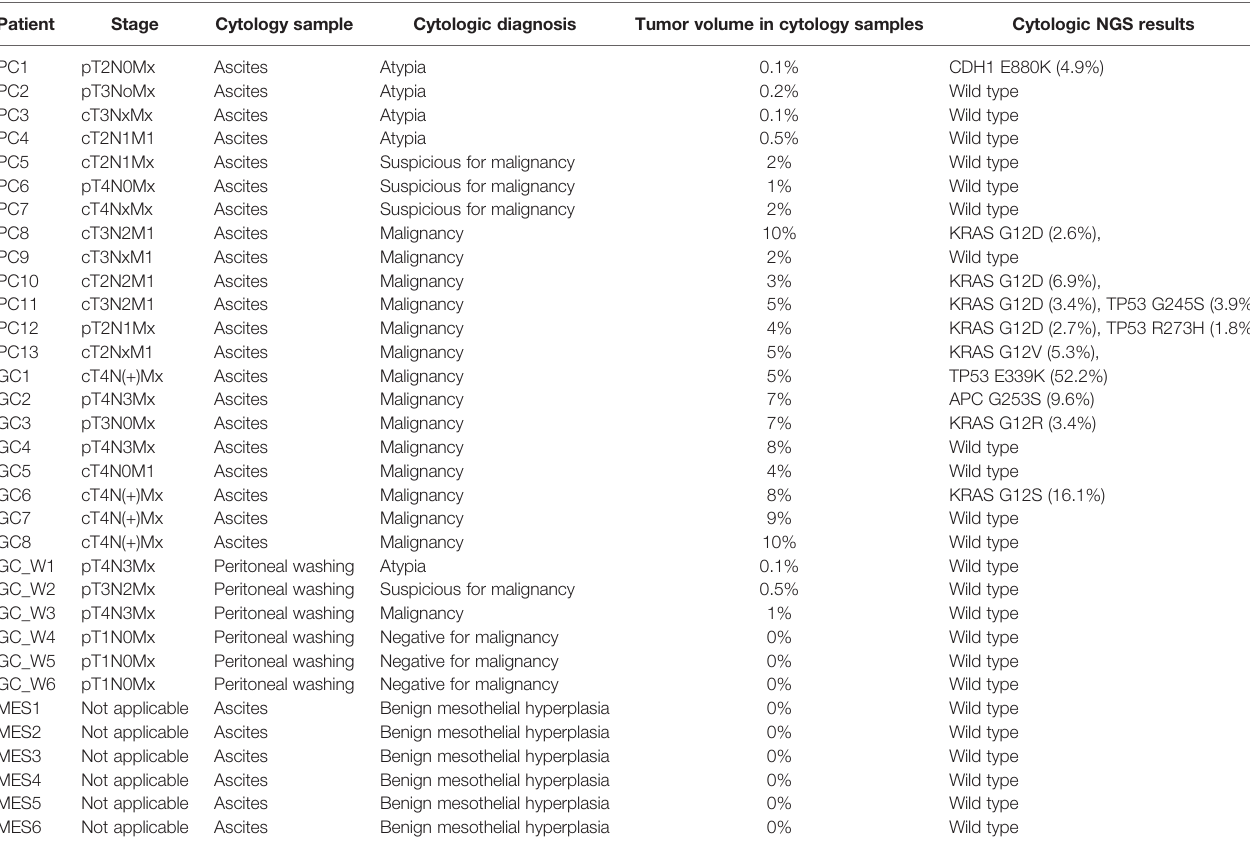
TABLE 4 | NGS results of cells obtained from ascites and peritoneal washing fl uid (n =